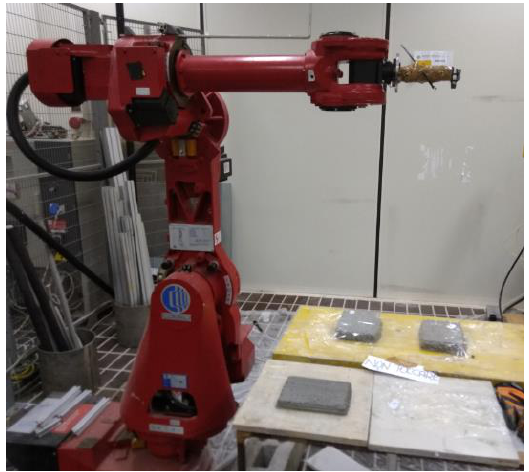
Figure 2. Three-axis robotic arm-based printing device.